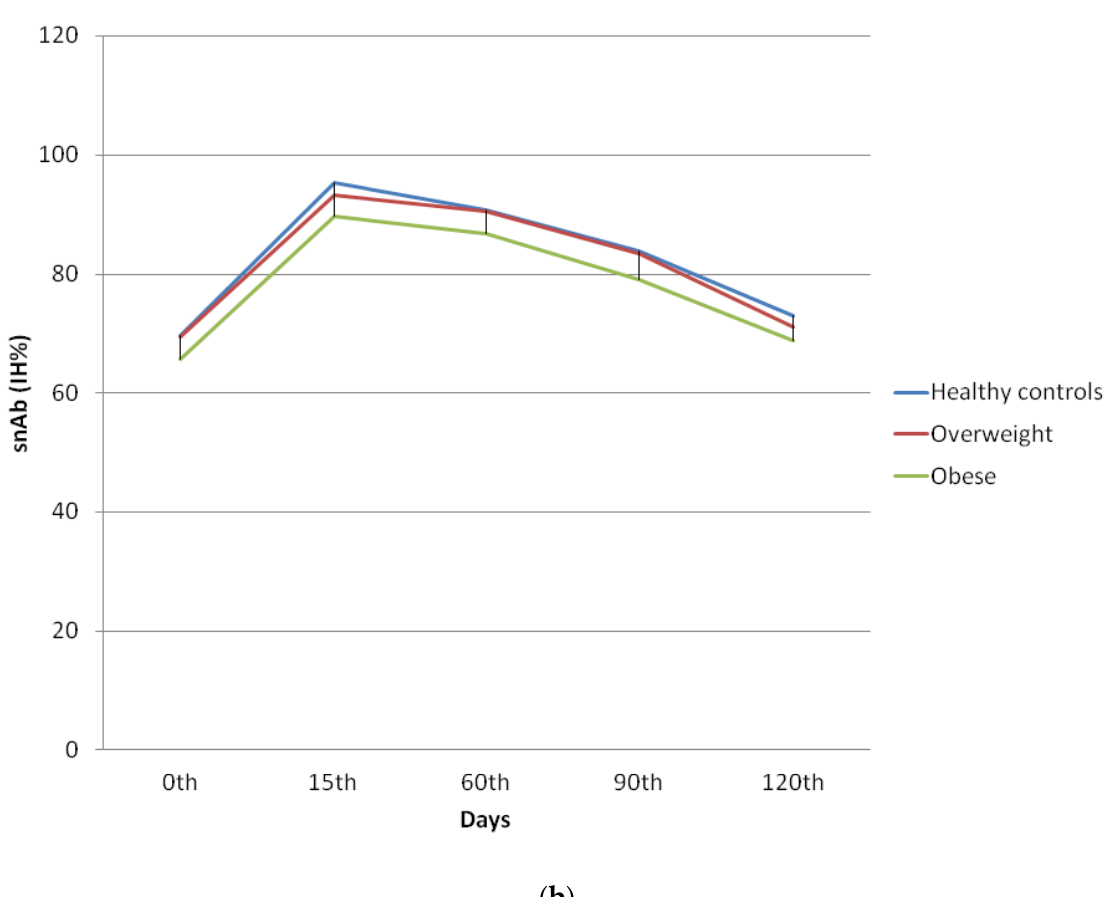
Figure 2. ( a ) Distribution of snAb IH% levels before and after the third dose of BNT162b2 vaccine (on the 15th, 60th, 90th, and 120th days) for all groups (box plots). ( b ) Distribution of snAb IH% levels before and after the third dose of BNT162b2 vaccine (on the 15th, 60th, 90th, and 120th days) for all groups (line plots). Anti-S-RBD IgG antibody titers and snAb IH% levels against SARS-CoV-2 were not correlated with IL-6 and TNFα levels ( p > 0.05).